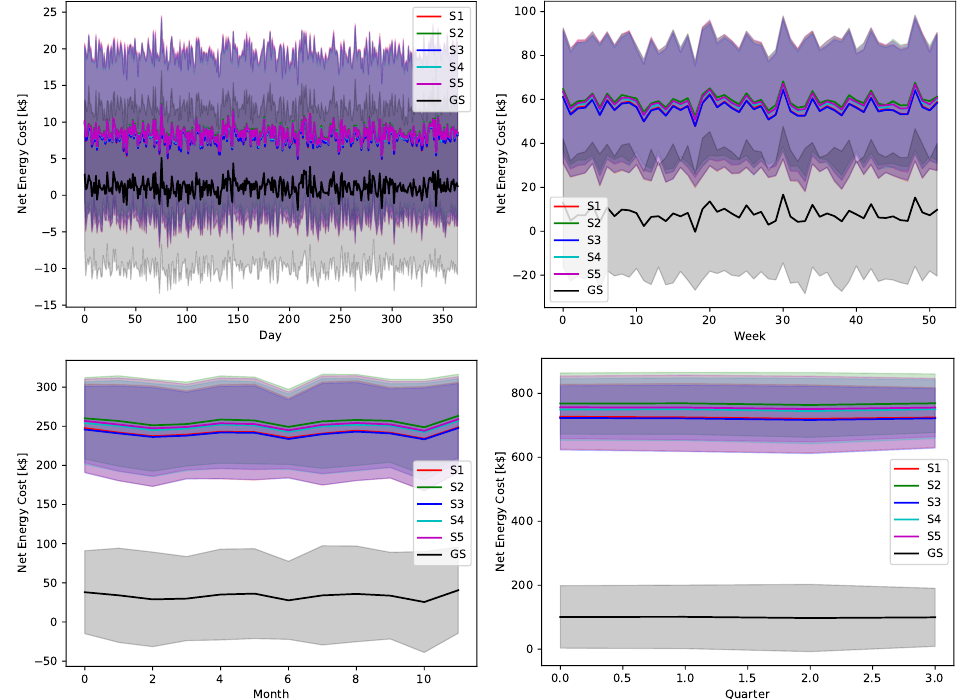
Figure 18. The total operation cost in terms of net energy purchase and sell revenue with a global certainty level U 10